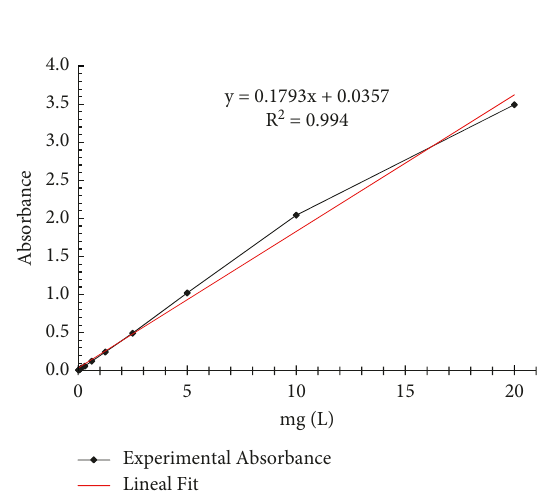
Figure 2: Diethyl (3H-1-ethoxy-3-phenoxazinylidene) ammonium chloride calibration